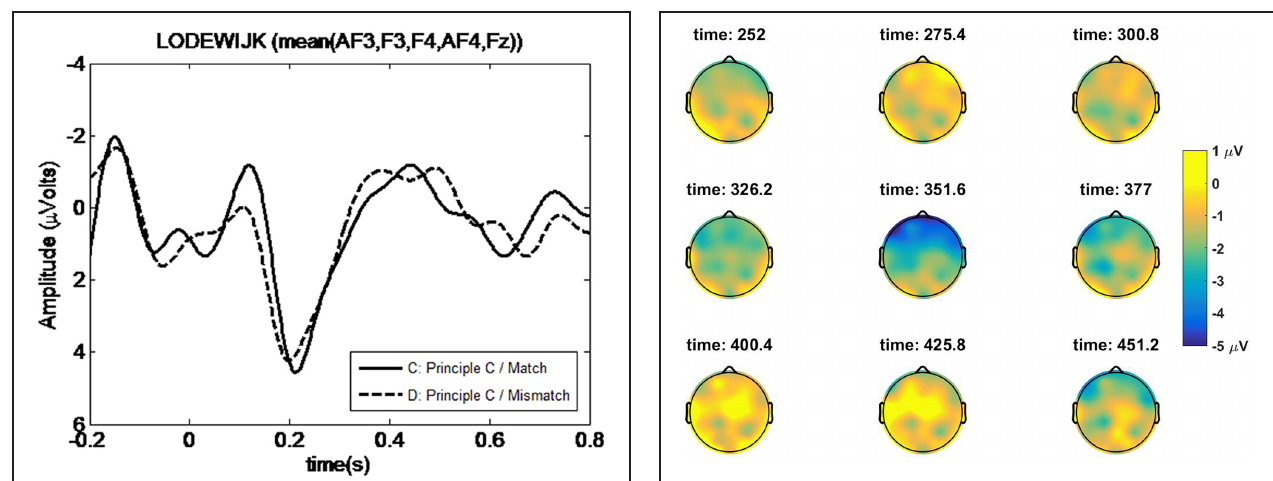
FIGURE 3 | Mean waveform at first potential antecedent Lodewijk position for Principle C Match and Mismatch conditions.